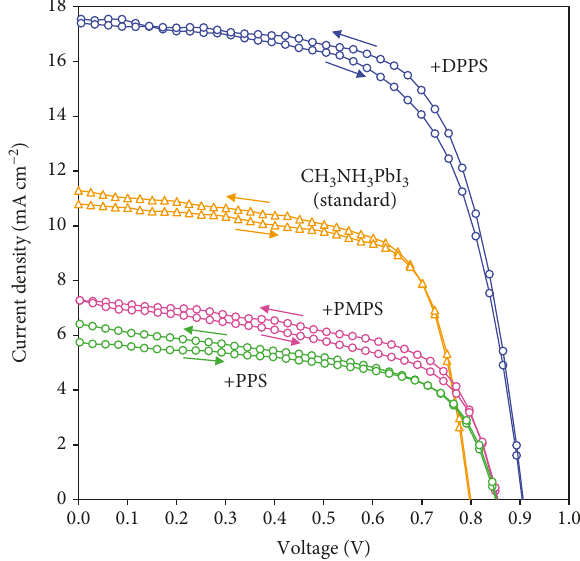
Figure 2: J - V characteristics of CH